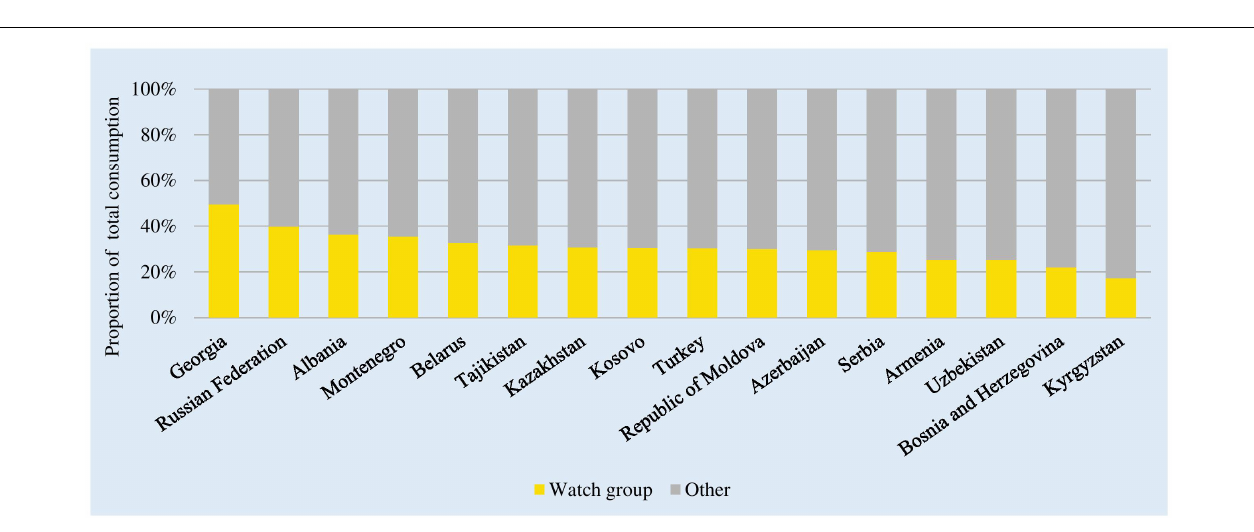
FIGURE 4 | Consumption of “Watch” group of antibiotics classes as a proportion of total consumption of antibacterials. Watch group: Quinolones (J01MA and J01MB); 3 rd generation cephalosporins (J01DD); macrolides (J01FA); glycopeptides (J01XA and A07AA09); antipseudomonal penicillins with beta-lactamase inhibitor (J01CR03 and J01CR05); carbapenems (J01DH); and faropenem (J01DI03). ∗ Kosovo [in accordance with United Nations Security Council resolution 1244